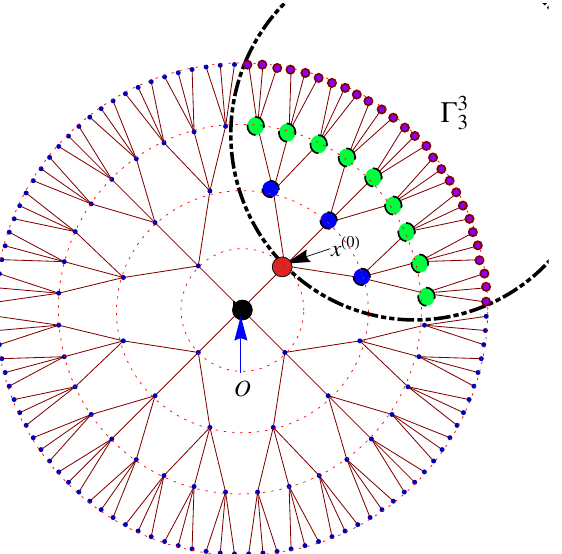
Figure 1. (Color online) The image denotes a fourth-order Cayley tree having 4 shells (or levels) by G 4.4 , where O is the root vertex of G 4.4 . The region separated by dashed lines represents a third-order semi-finite Cayley tree with 3 shells and will be denoted by Γ 3 3